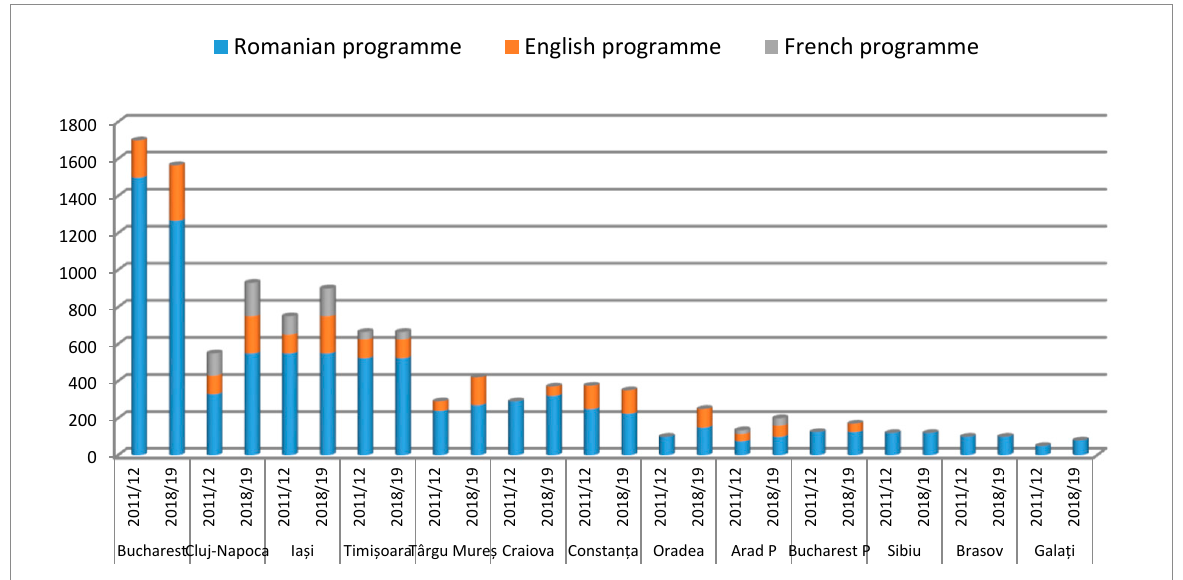
Figure 2. Trends regarding the number of new-entrant places in medicine by medical school in 2011–2012 and 2018–2019 according to OECD.